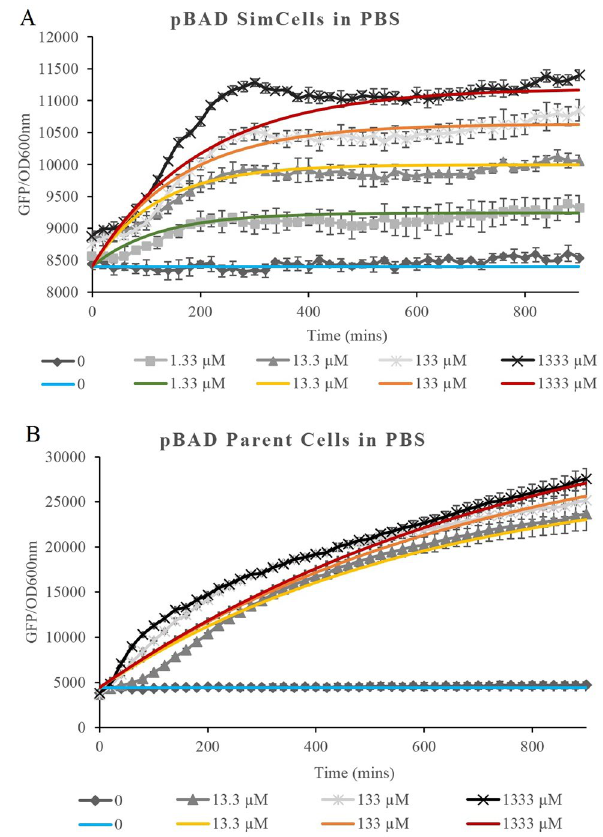
Figure 4. Experimental (black and white) & modelled (coloured) data of the induction over time as determined by GFP fluorescence per unit OD at 600 nm of ( A ) pBAD SimCells in PBS with L-arabinose and ( B ) pBAD Parent Cells in PBS with L-arabinose.